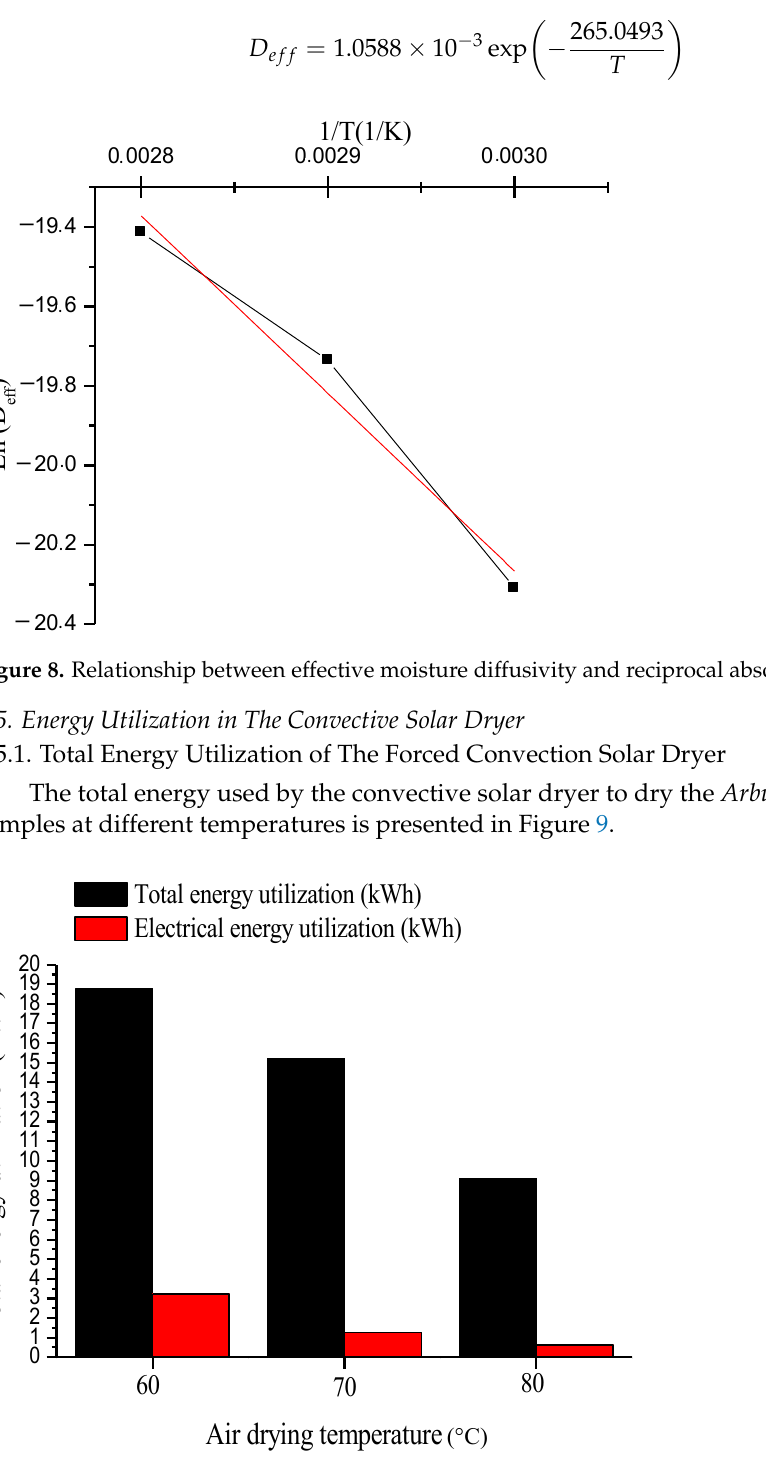
Figure 7 . Effects of both air flow and temperature on the effective diffusion coefficient. The activation energy is defined as the amount of energy needed to remove moisture of a solid sample. Higher value of the activation energy means higher temperature sensi ‐ bility of the Deff coefficient [62]. The average activation energy recorded for Arbutus un ‐ edo L. is 2203.46 kJ/kg with an R 2 of 0.9486 (Figure 8). Similar results were reported for white mulberry [69], and for black mulberry fruits [57].